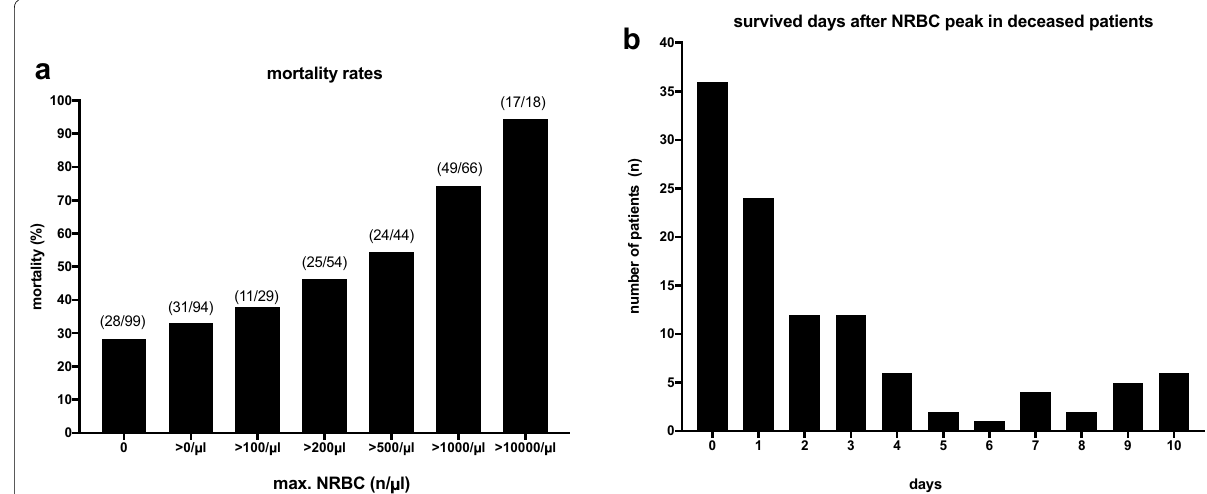
Fig. 3 a ICU mortality rates of ARDS patients in relation to the maximum concentration of nucleated red blood cells (NRBCs) in the peripheral blood. Numbers in parenthesis denote the ratio of deceased patients to all patients with the respective NRBC concentration. b Frequency distribu‑ tion of the number of survived days after reaching the individual NRBC peak value in deceased patients. Data are presented as a histogram indicat‑ ing the number of patients in relation to survived days